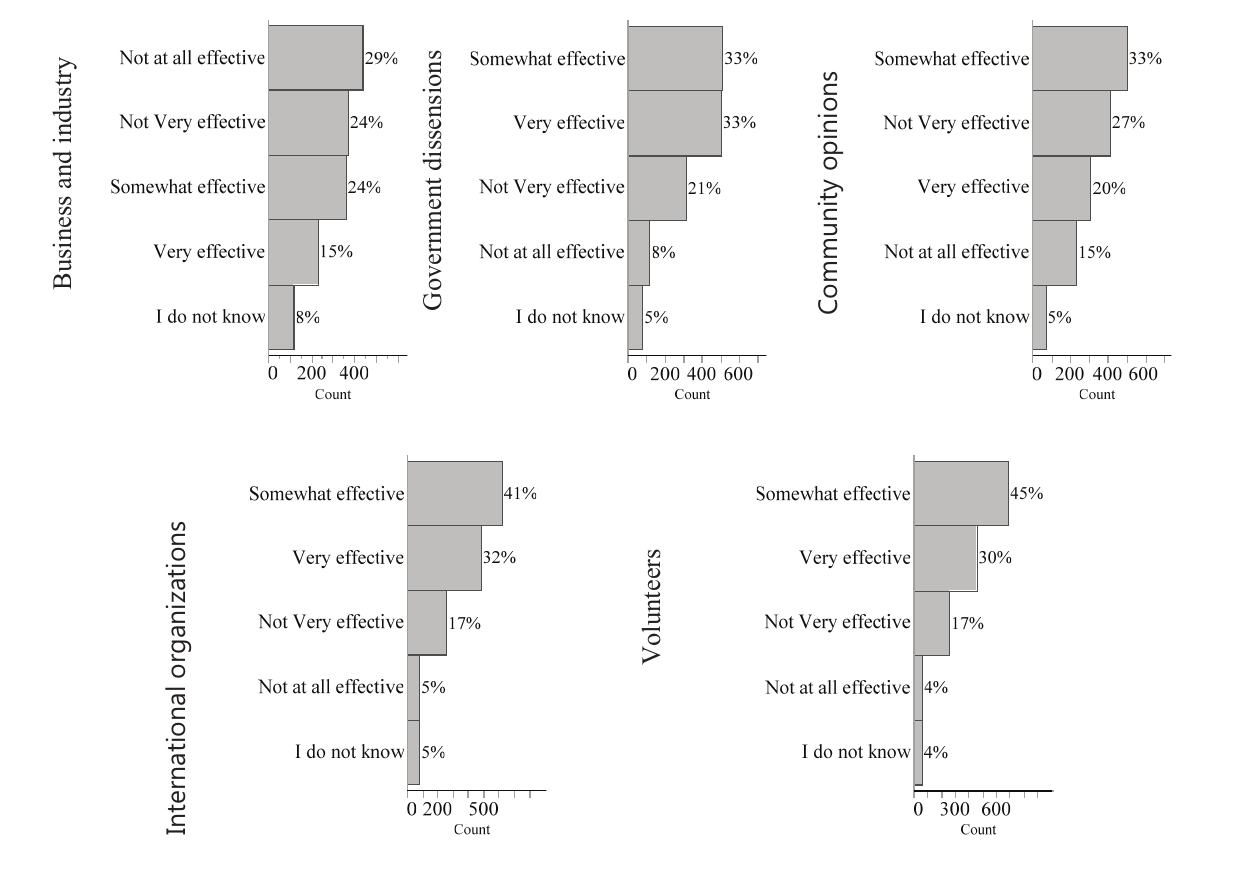
FIGURE 6 | Responses to the question: How effective are the following in tackling coastal environmental issues at the coastline or in the